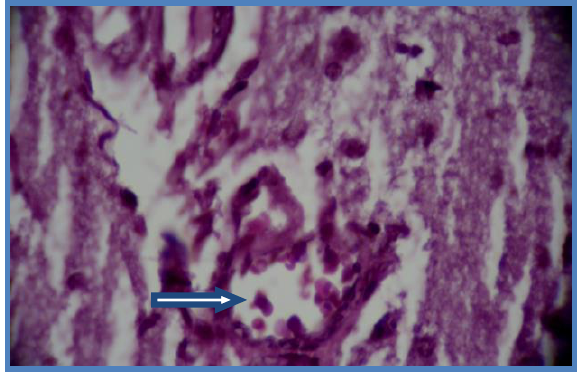
Figure, 3: Cerebral Odema, Congestion in the Brain Tissue and Meninges with Vaculation in the Infected Brain Tissue of Mice with Isolated Virus Stained with (H and E)